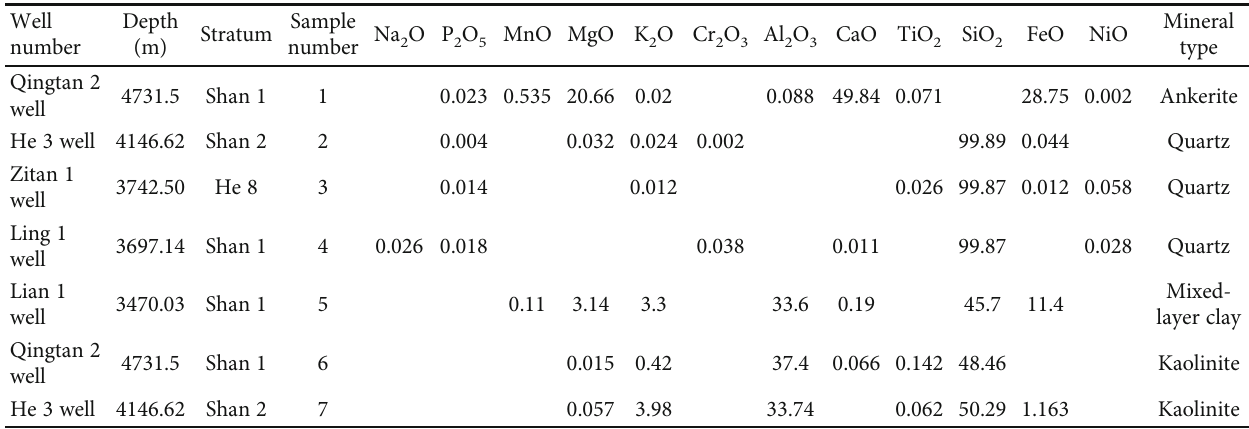
Table 2: Electron probe microanalysis of the compositions of sandstone cements in the Upper Paleozoic Erathem in the southwest of study